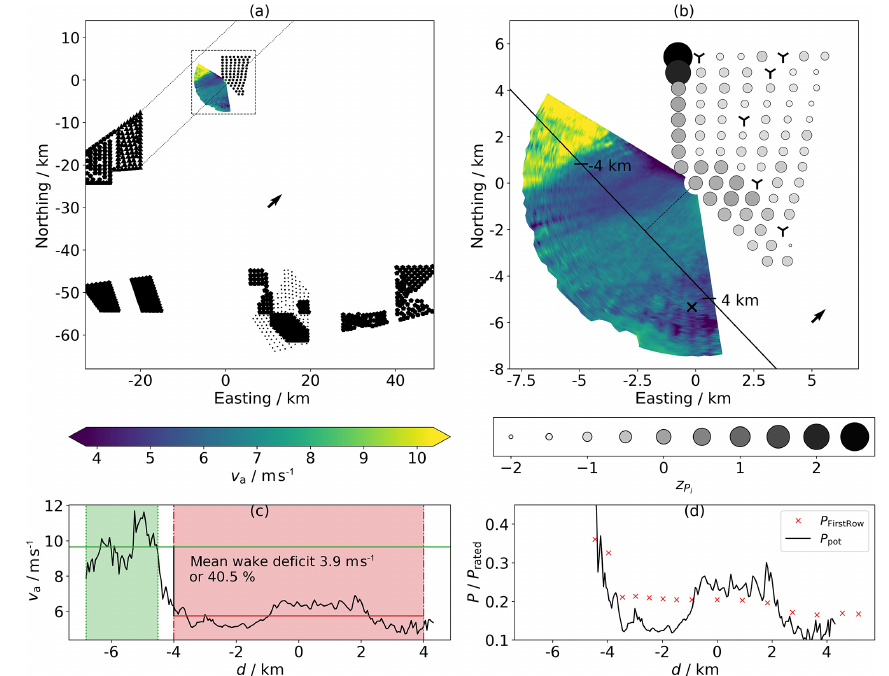
Figure 6. Lidar scan (scenario B from Table 2) on 6 February 2019 16:58–17:01UTC: (a) overview of the situation in the German Bight with lines parallel to the wind direction retrieved from the lidar scan from the corners of the upstream wind farm cluster BorWin. Lidar wind speed is colour coded (left colour bar). (b) Close view of the lidar wind field and the wind farm GT I. The z score of the not curtailed wind turbines’ power in the current 10min interval (16:50–17:00UTC) is in greyscale (right colour bar), curtailed or non-operating turbines are marked ( Y -shaped marker). Markers scale with z − z min . Turbine numbers to calculate the z score as in Fig. 5. The substation Hohe See ( × ) is marked. The solid line marks a virtual wake cut 3000m upstream of turbine GT58 on which the wind field is evaluated and drawn in (c) . Areas of wake and free stream are shaded manually, the resulting wake deficit is stated. (d) Available power on hub height along the wake cut from (b) together with the power achieved from the upstream turbines in GT I with their positions projected to the wake